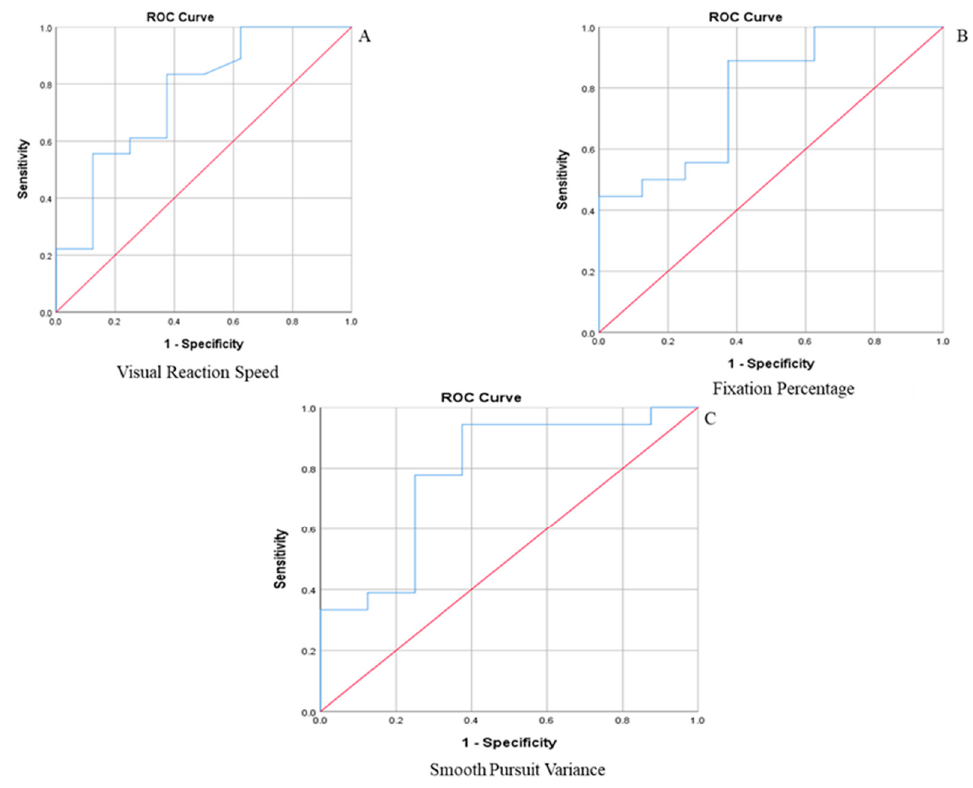
Figure 1. ROC for CSP’s: ( A ) Visual Reaction Time Speed (AUC = 0.706); ( B ) Fixation Percentage (AUC = 0.785); ( C ) Smooth Pursuit Variance (AUC = 0.785).